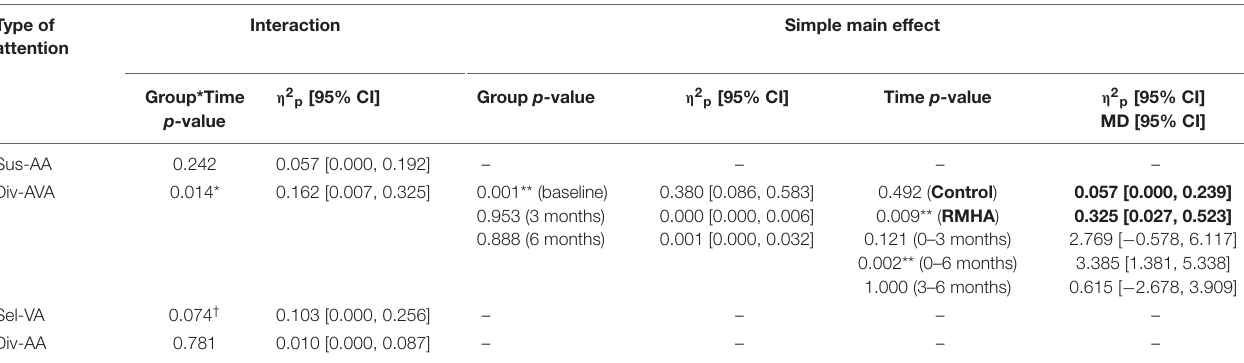
TABLE 7 | The p -values, η 2 p and CIs of the effect size, of the four TEACh conditions. Type of Interaction Simple main attention